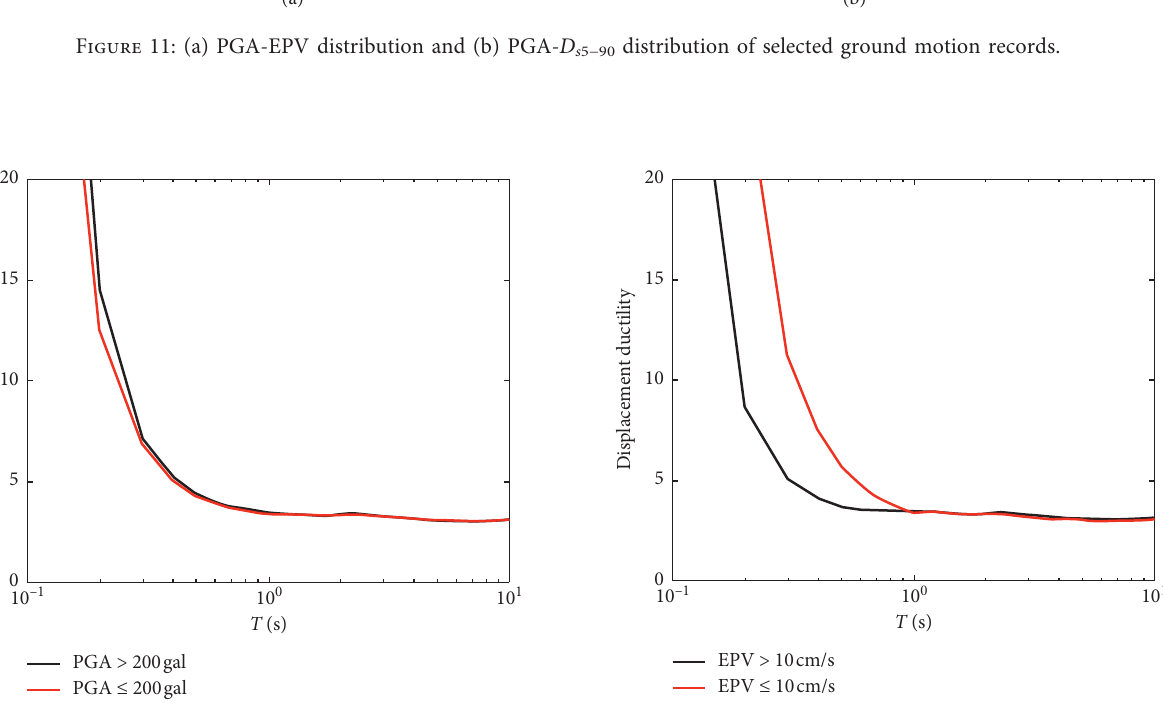
s 5 − 90 distribution of selected ground motion records.